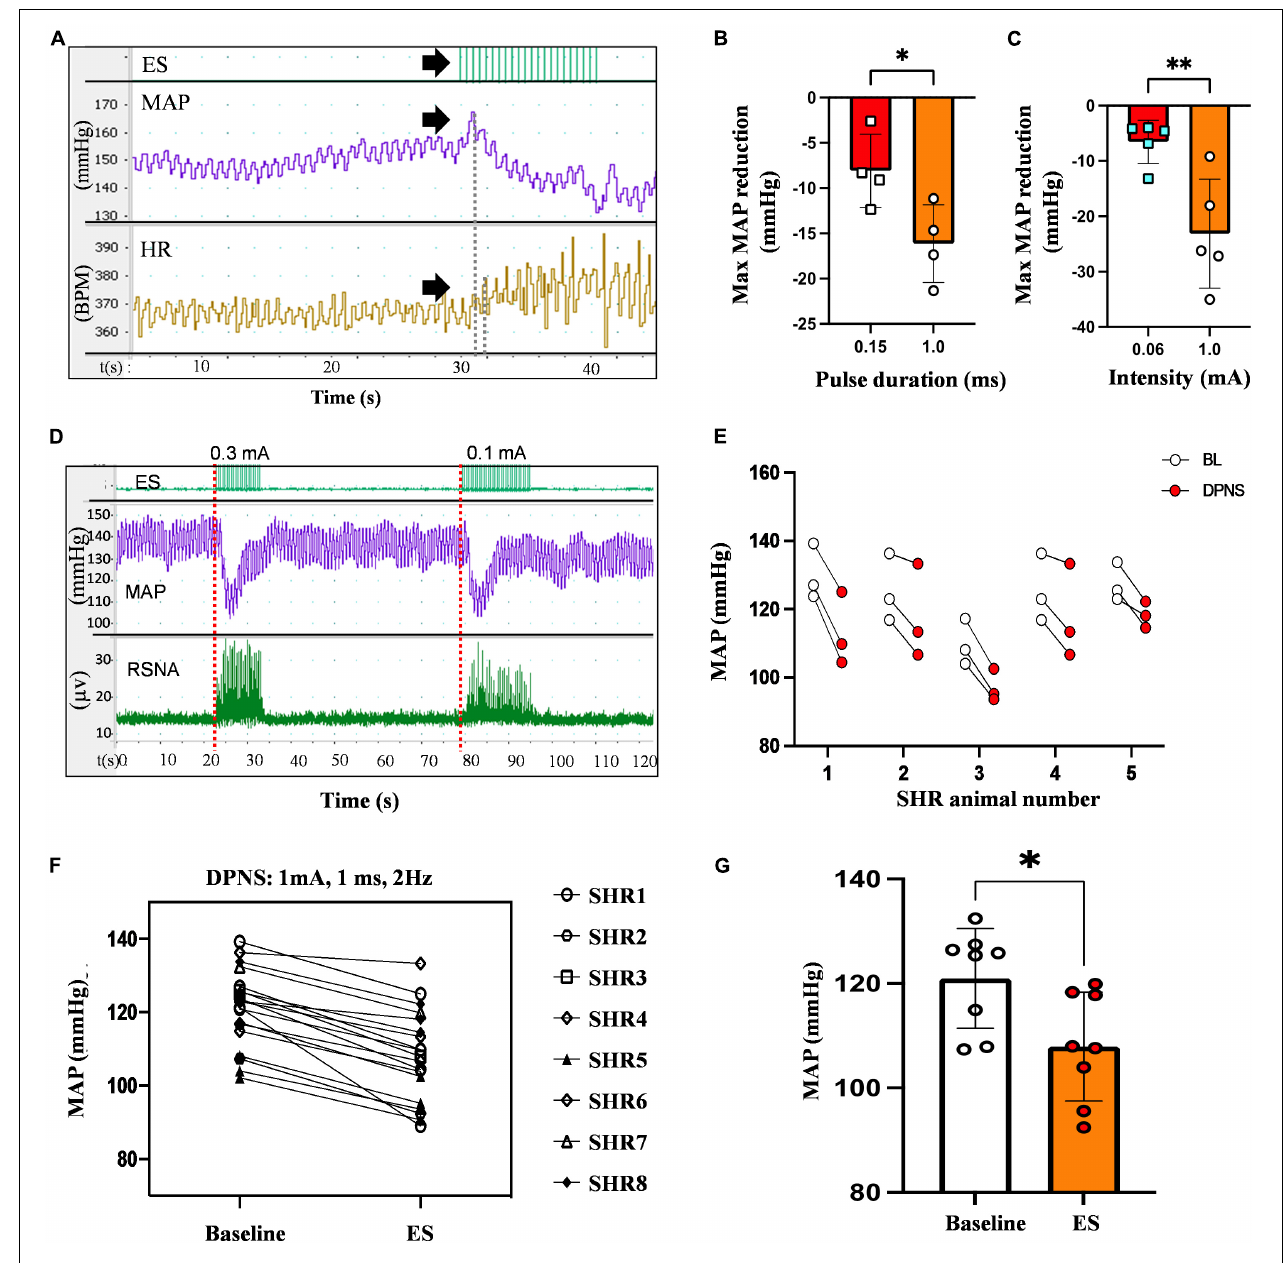
FIGURE 2 | Reduction in MAP by DPNS. (A) Stimulation of the DPN at 2 Hz (arrows) evokes a reduction in MAP and increases the SRNA (red dotted lines). (B) 1 ms pulse duration and (C) 1 mA pulse amplitude induced more effective MAP depressor responses (unpaired t-test; * p < 0.05; ** p < 0.008, n = 4–5). (D) Reproducible MAP reduction evoked by two sequential DPNS trains. (E) MAP reduction evoked by three consecutive trains of DPNS in five individual SHR animals. (F,G) 1 ms pulses induced a reduction in MAP in each animal and a significant reduction in MAP compared to baseline (unpaired t -test; ** p < 0.02, n = 8). ES, electrical stimulation, MAP, mean arterial pressure; HR, heart rate; BPM, beats per minute; RSNA, renal sympathetic nerve activity; DPN, deep peroneal nerve.